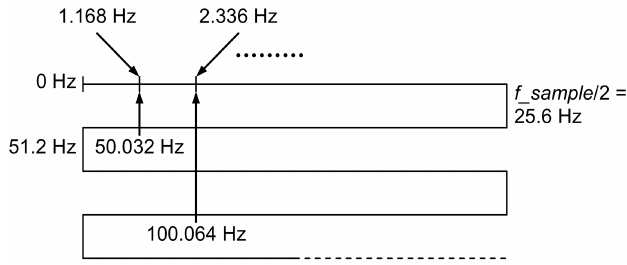
Figure 6. Alias e ff ect during sampling of the electrical network noise with a sampling frequency of 51.2